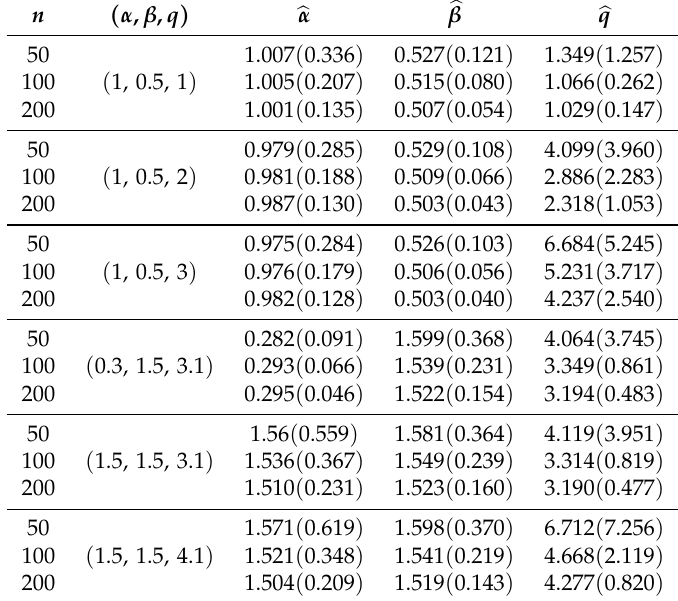
Table 4. Mean of each maximum likelihood (ML) estimate with standard deviations in parentheses.